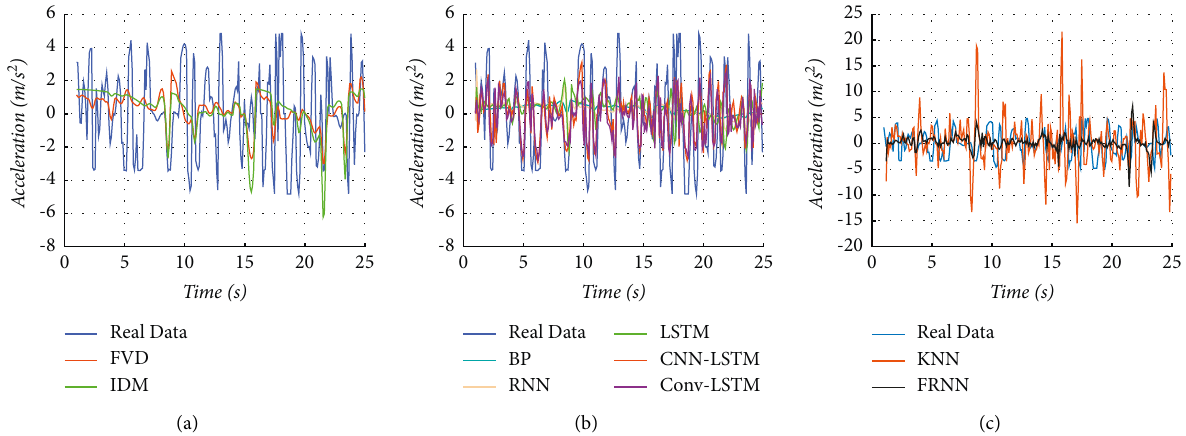
Figure 10: Acceleration comparison of continuous traffic flow. (a) Conventional models. (b) ANN CF-A. (c) ML CF.